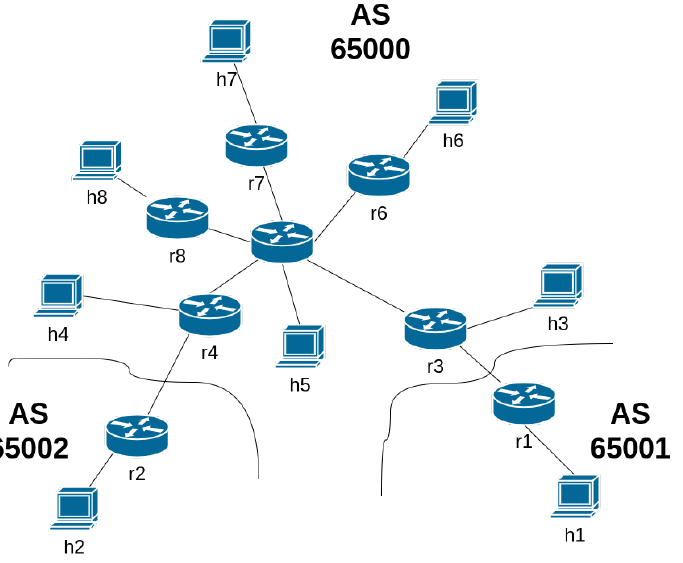
Figure 3. Use-case of legacy routing